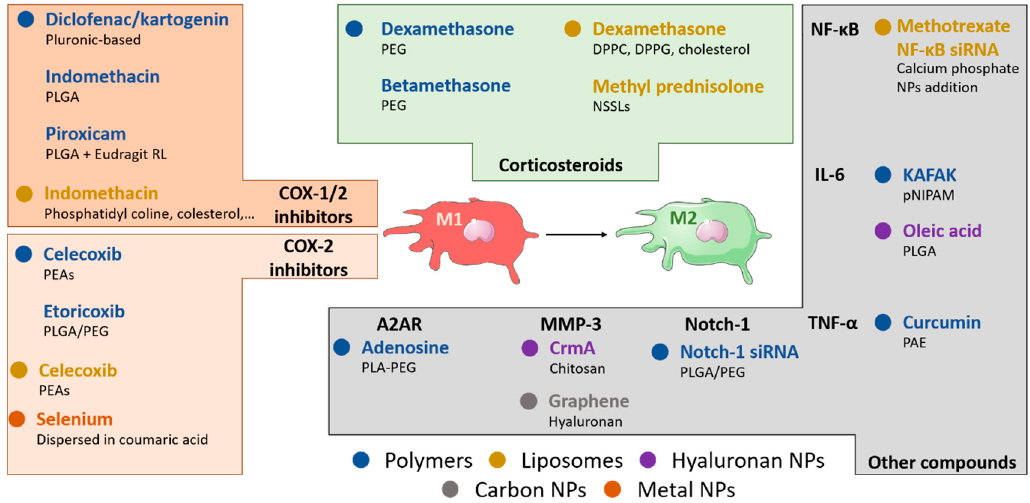
Figure 3. Nanotechnological approaches targeting macrophages in OA. Nanomedicine o ff ers a wide range of drug delivery systems to inhibit the pro-inflammatory activity of M1-like macrophages in OA joints. Polymeric and hyaluronan-based nanoparticles (NPs) and liposomes have been investigated to inhibit inflammation by delivering non-steroidal anti-inflammatory drugs (NSAIDs, i.e., indomethacin, diclofenac, etc.) for COX-1 / 2 inhibition, COX-2 specific inhibitors (i.e., celecoxib and etoricoxib) or corticosteroids (i.e., dexamethasone, betamethasone, and prednisolone) to block glucocorticoid receptor in OA joints. NPs loaded with other pharmacological molecules have been used to selectively block the release of specific cytokines, such as IL-1 β by IL-1Ra or IL-6 by KAFAK peptide. Clodronate-loaded liposomes were also used to deplete macrophages in experimental settings, showing mixed results. Metabolic or genetic manipulation of macrophages was explored using NPs to deliver adenosine and NF- κ B or Notch homolog 1, translocation-associated (Notch-1) siRNAs. These approaches have showed promising experimental results related to the reprogramming of macrophages toward the M2 anti-inflammatory phenotype in the joint microenvironment, thus becoming potential candidates to improve the current treatment of OA disease.